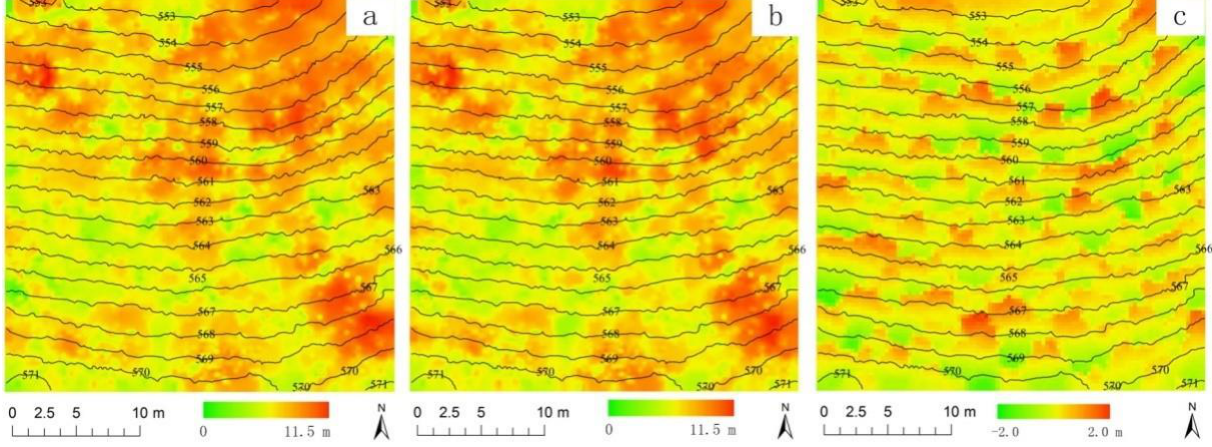
Figure 6. Canopy model heights (CHMs) before and after correction and difference image in plot No. 34: ( a ) CHM I before correction ( b ) CHM II after correction; ( c ) image of the